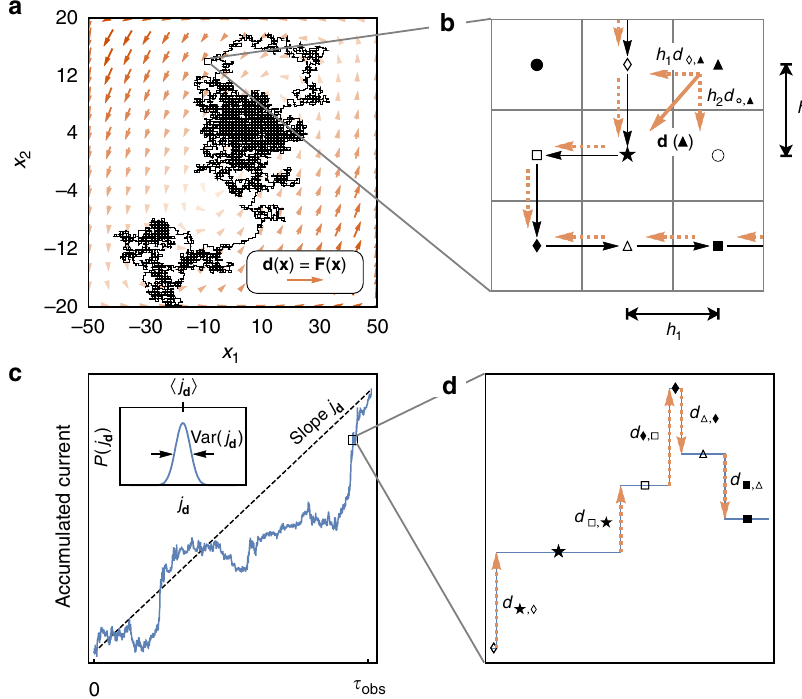
Fig. 3 Extracting current fl uctuations from trajectories. a A realization of a long trajectory diffusing through con fi guration space. The macroscopic current is computing by choosing a vector fi eld d ( x ), here chosen as the thermodynamic force fi eld F ( x ). b On the microscopic scale, the trajectory may be modeled as discrete jumps between neighboring lattice sites (here labeled with symbols: lozenge, star, square, … ). The continuous-space vector fi eld is decomposed into components along the direction of possible jumps, i.e., d evaluated at the black triangle site can be expressed in terms of the weight d ◊ , ▲ associated with a jump from the black triangle to the white diamond. c A realization of the trajectory gives a single value of the empirical current j d . By recording many realizations, the empirical current distribution P ( j d ) is sampled to give 〈 j d 〉 and Var( j d ) (inset). In the case that d = F , the mean slope of this accumulated current is the average entropy production rate. d The empirical current for a single realization is constructed as the sum of the d weights for